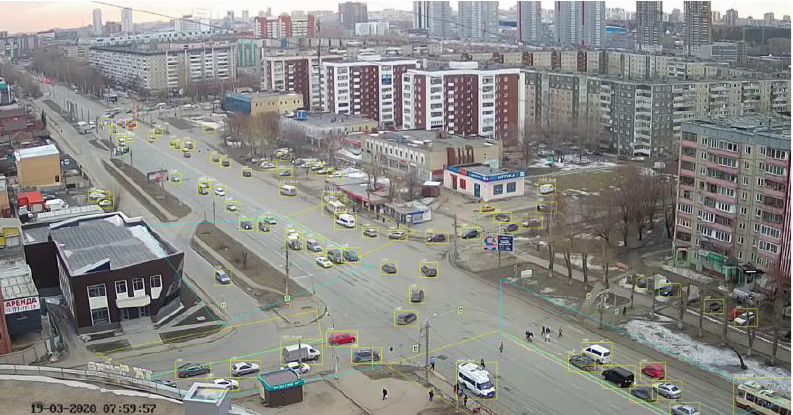
Figure 2. An example of processing an input image and marking the boundaries of the control zones.